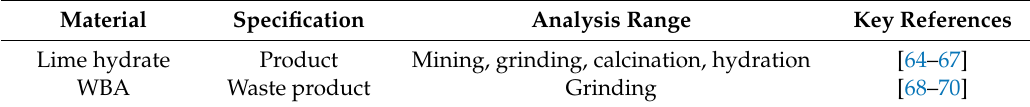
Table 3. Energy and emission data